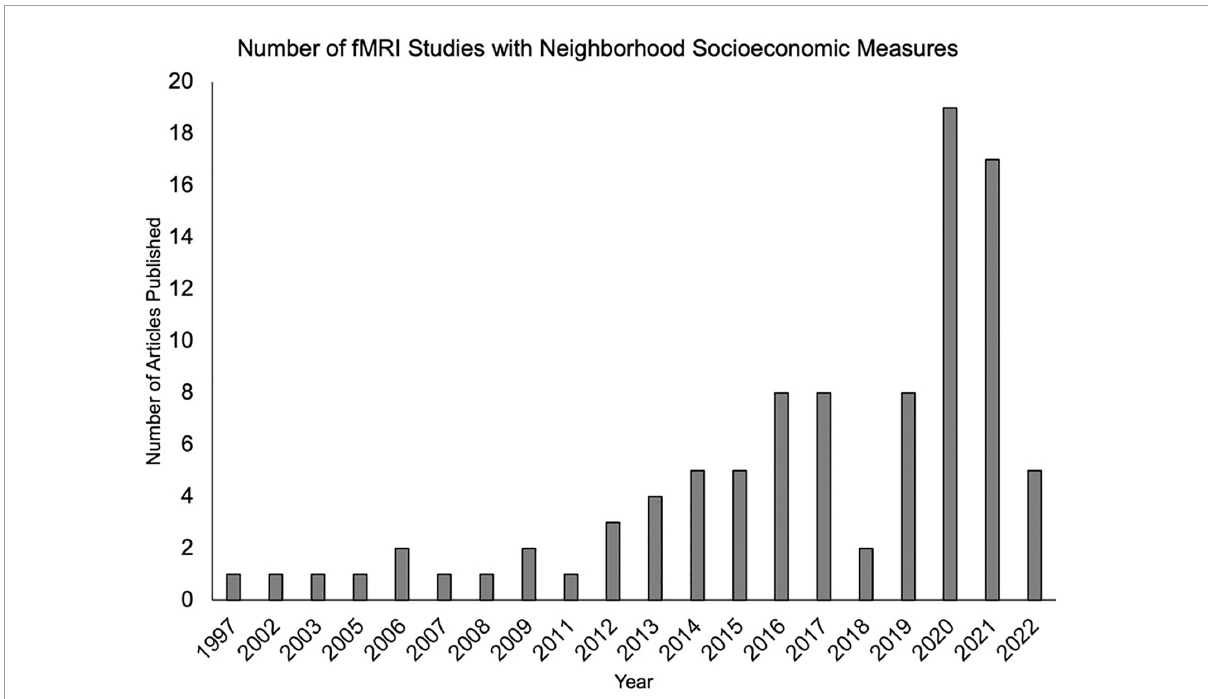
FIGURE1 An increasing number of functional magnetic resonance imaging studies are examining neighborhood-level socioeconomic factors. Articles were identified by the authors using a PubMed search which included functional magnetic resonance imaging (fMRI) and at least one neighborhood term (neighborhood disadvantage, neighborhood deprivation, neighborhood poverty, concentrated disadvantage, and concentrated